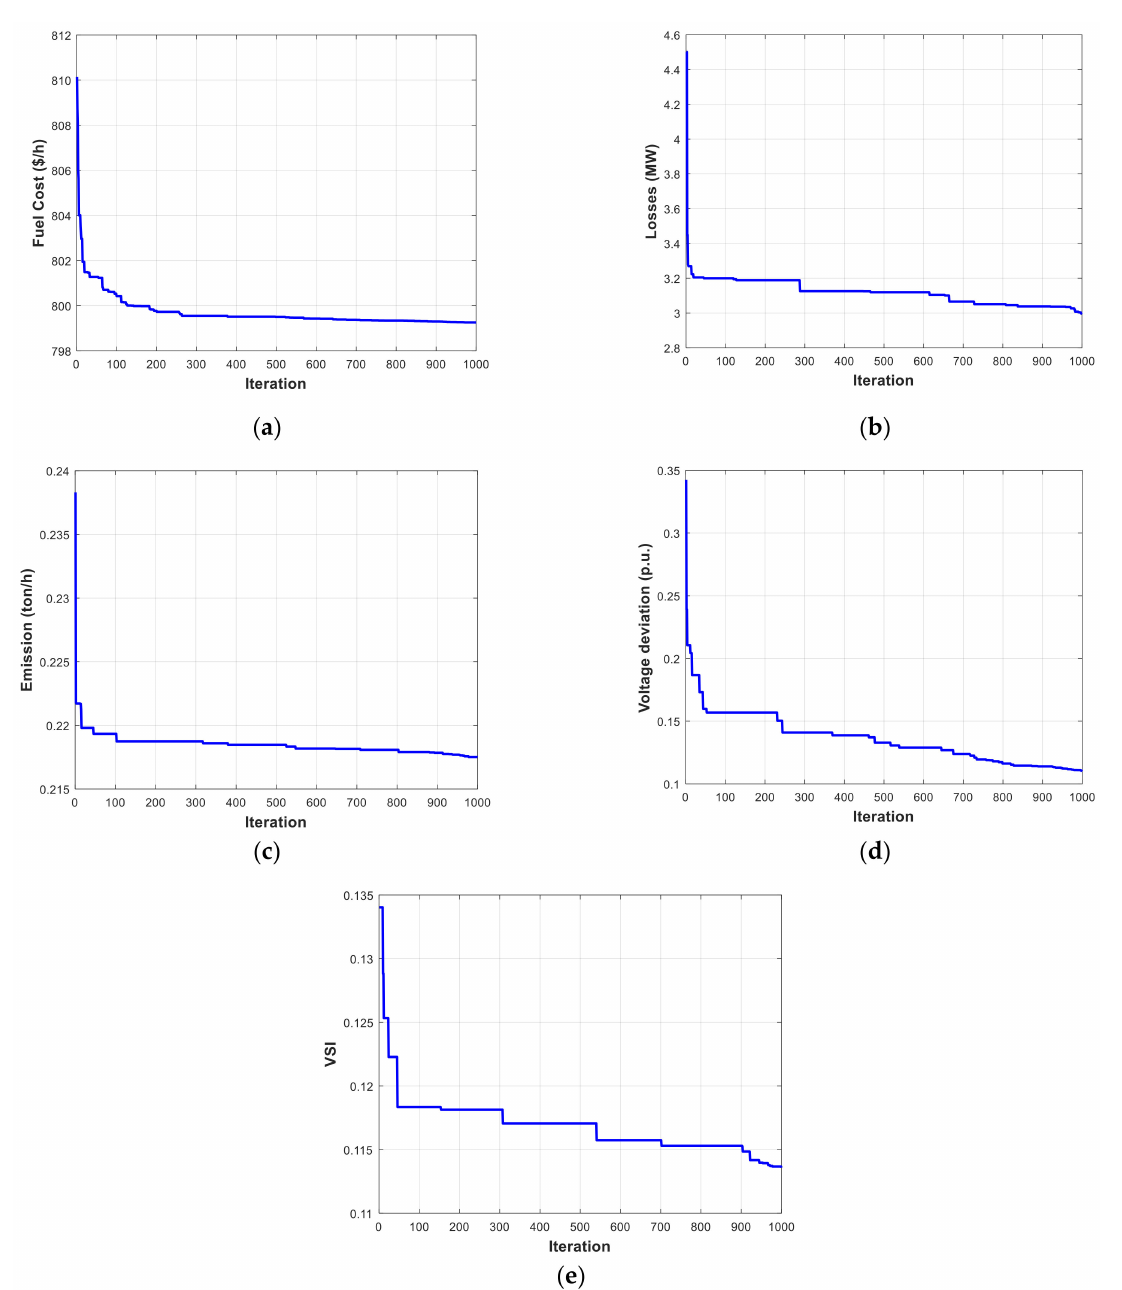
Figure 5. The convergence characteristics of the SMA algorithm for Cases 1–5. ( a ) Case 1, ( b ) Case 2, ( c ) Case 3, ( d ) Case 4, ( e ) Case